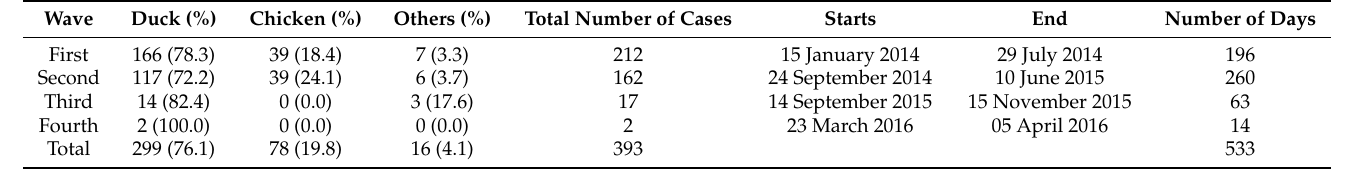
Table 1. Distribution of HPAI H5N8 outbreaks per specie, type, and period in